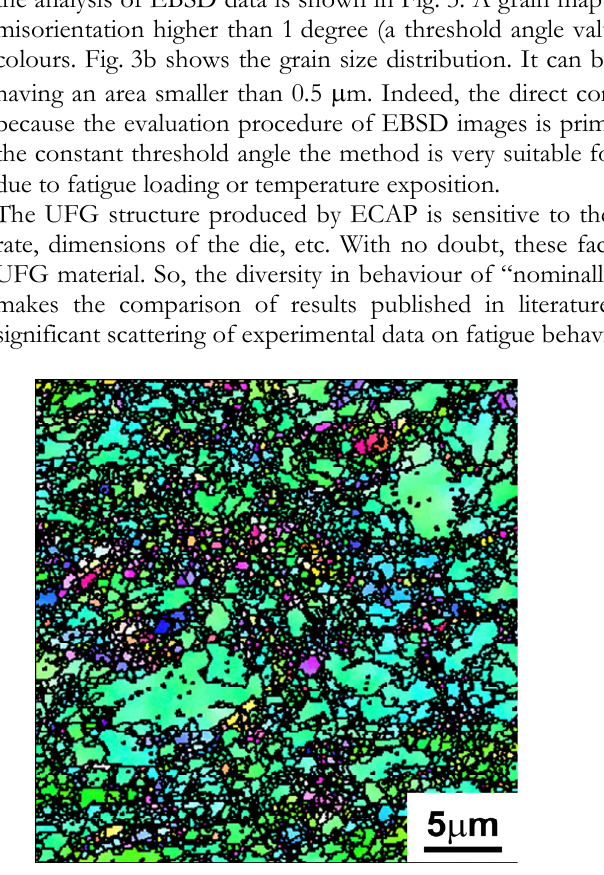
Figure 3a: Grain map of UFG Cu as displayed by EBSD. Figure 3b: Analysis of the grain size and grain size distribution.